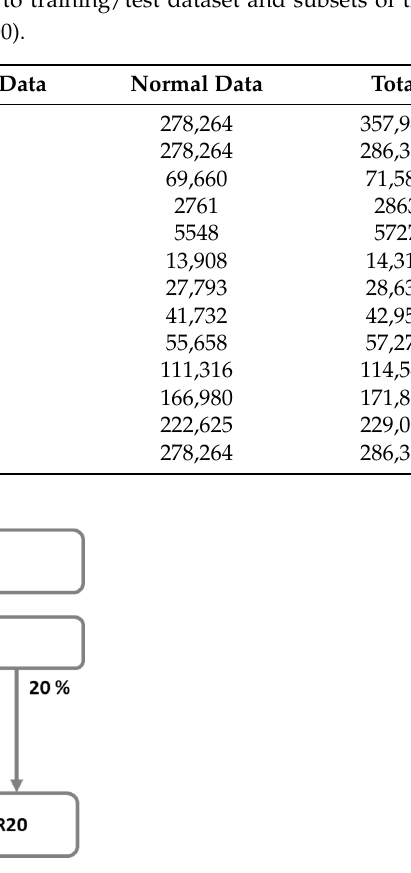
9 of 23 Table 1. Random distribution of DS2OS dataset to training/test dataset and subsets of training da- taset (D1, D2, D5, D10, D15, D20, D40, D60, D100).